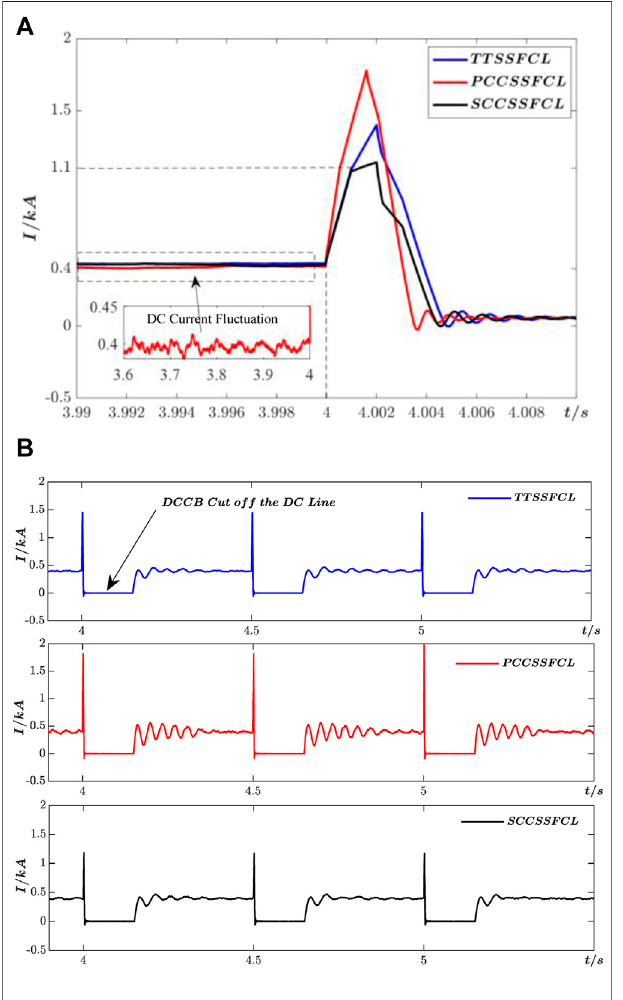
FIGURE 7 | Waveforms of the DC current of the three SSFCLs. (A) WaveformsoftheDCcurrentwhenthefaultoccursat4.0 s. (B) Waveformsof the DC current under three repetitive short-circuit faults.